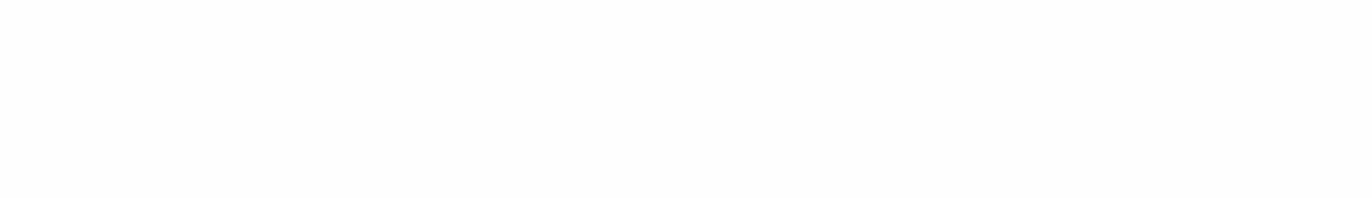
FIGURE The generation of a Sierpinski carpet by itera- tire mapping using (a) a scaling factor 1/3, the size of the squares tends to zero; (b) a scaling factor r= 1/3, the size of the cluster tends to infinity. In (a) the lacunas, which appear in course of iteration, are indicated for the first two steps.